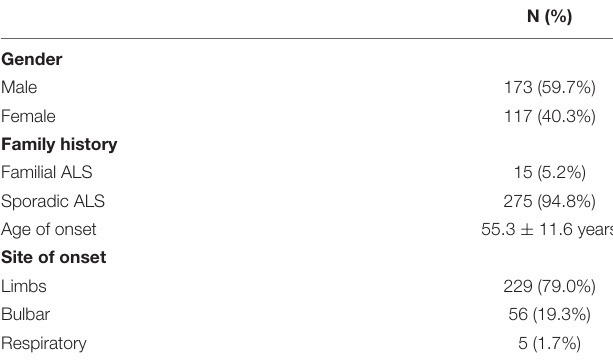
TABLE 1 | Characteristics of the ALS patients in this